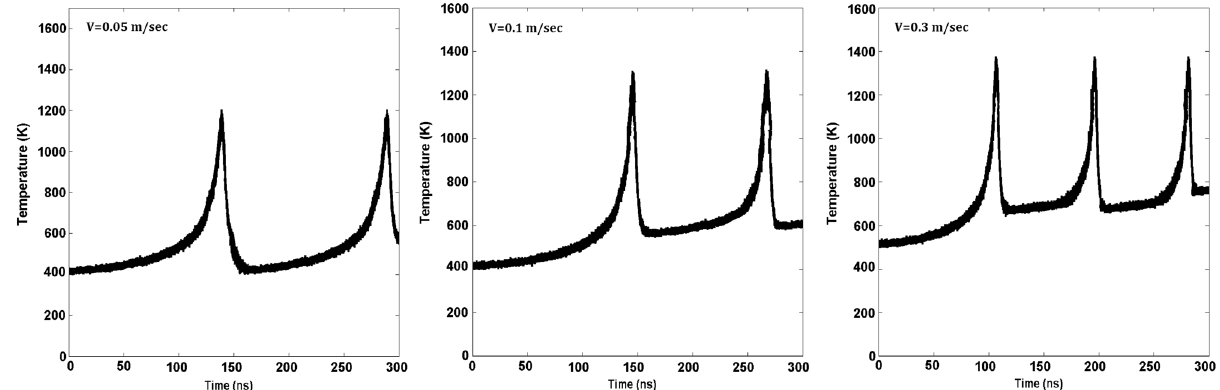
Figure 4. Temperature profiles during flash heating events in Structure C for several velocities.